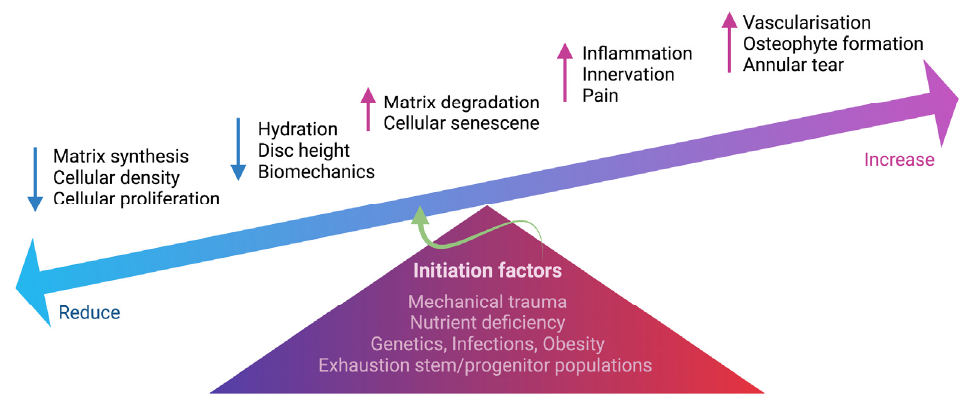
Figure 2. Schematic summarizing the degenerative events in IVD. Multifactorial conditions initiate degenerative processes in the IVD, including mechanical trauma, nutrient deficiency, genetic predisposition, infections, obesity and exhaustion of stem and progenitor cells. The change in IVD cellularity, including cell density, proliferation and cell senescence, can cause an imbalance of ECM homeostasis. Increased matrix degradation and reduced matrix synthesis result in reduced hydration and disc height. Increased inflammation also causes the ingrowth of nerve fibers into the IVD, contributing to discogenic pain. Vascularization, annular tear and osteophyte formation are also present during IVD degeneration. The schematic was created with